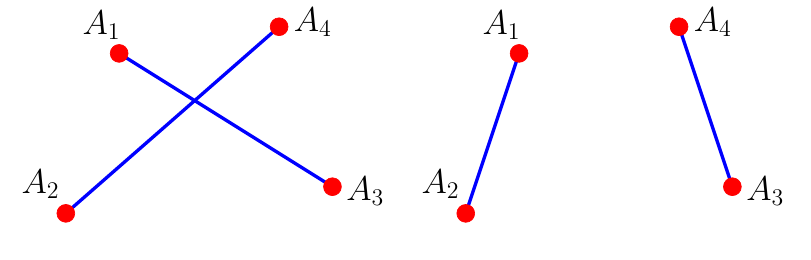
Figure 5. Cases with the convex hull being a